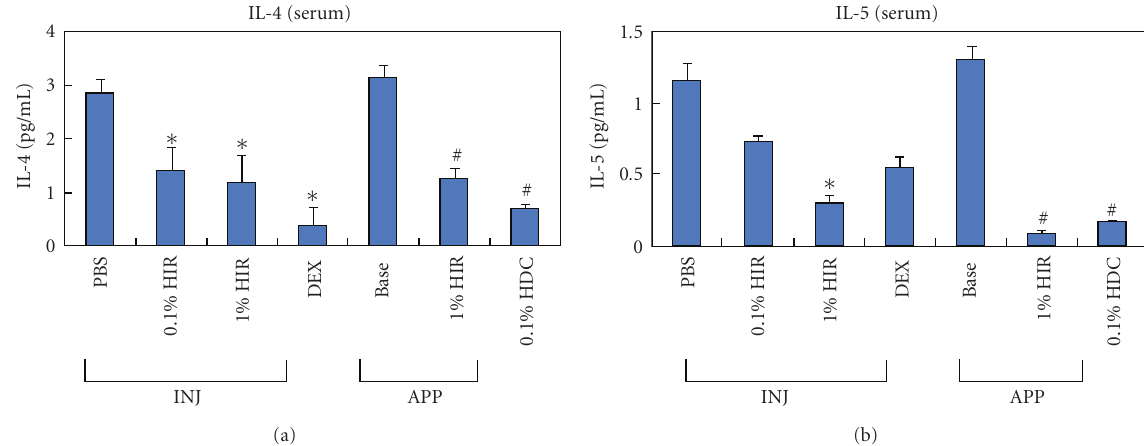
Figure 4: Changes in cytokine levels after HIR treatment. HIR significantly decreased the levels of IL-4 and IL-5 in the AD-like skin lesions of NC/Nga mice, but IL-13 levels were not significantly decreased. Analyses were repeated at least three times. Data are mean ± S.D. HIR: Hirsutenone, DEX: dexamethasone, Base: Baseline, HDC: hydrocortisone cream, INJ: injection, APP: application. ∗ P < .05 compared with the PBS group. # P < .05 compared with the Base group. n =